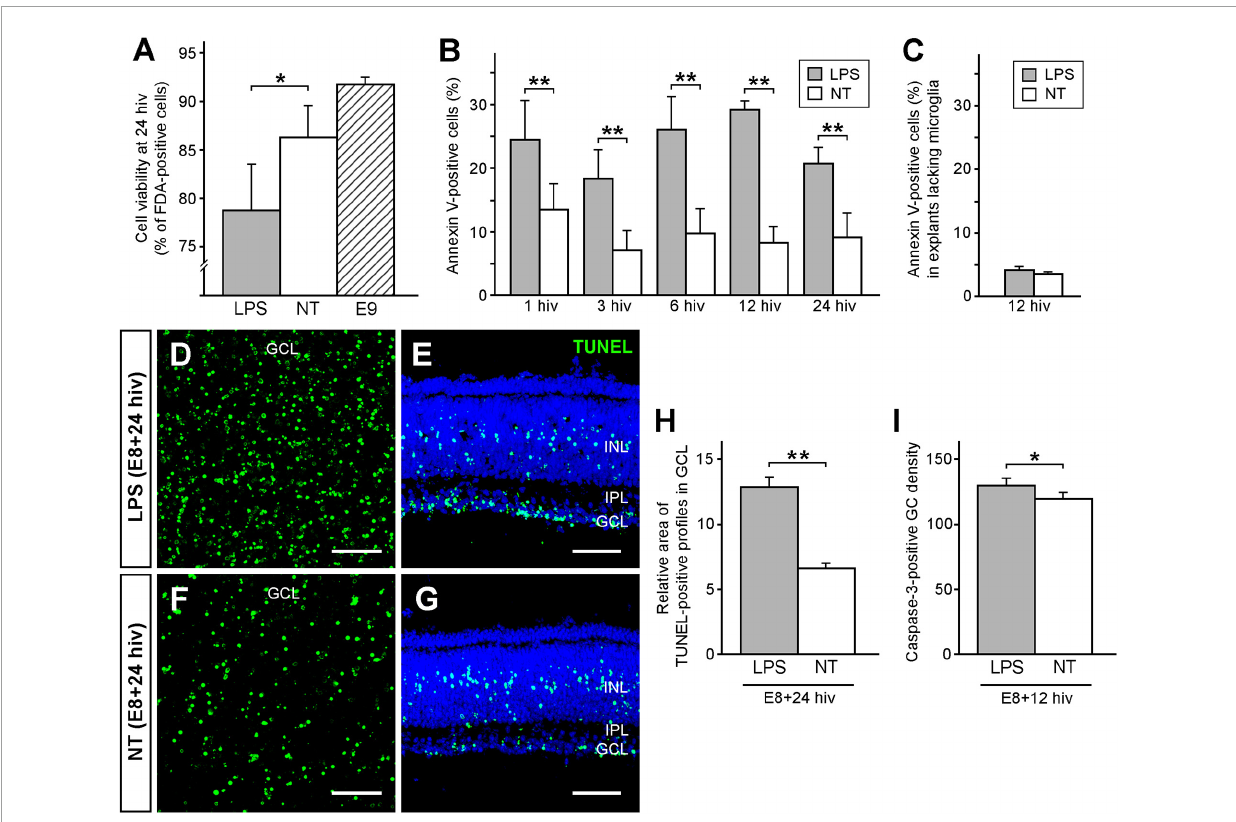
FIGURE2 LPS treatment decreases cell viability and increases cell death in retina explants prepared from quail embryos cultured for 24 h in vitro (E8 + 24 hiv). (A) Cell viability in LPS-treated (LPS, grey bar) and non-treated (NT, white bar) E8 + 24 hiv retina explants compared with that in non-cultured E9 retina explants (E9, striped bar). Cell viability is expressed as the percentage of fluorescein diacetate (FDA)-positive cells from the whole cell population, which was obtained by flow cytometry analysis of retina explant cell suspensions treated with FDA, that labels viable cells, and propidium iodide, that stains dead cells. Data are expressed as means ± SEM ( n = 9 for each condition). The percentage of viable cells is significantly lower in LPS-treated E8 + 24 hiv retina explants versus non-treated explants, while it is not significantly different between non-treated explants and non-cultured E9 retina explants (* P < 0.05, one-way ANOVA followed by Tukey test for multiple comparisons). (B) Percentages of annexin V-positive cells in E8 retina explants cultured for 1, 3, 6, 12, and 24 hiv in the presence (grey bars) or the absence (white bars) of LPS, as determined by flow cytometry analysis of cell suspensions from retina explants stained with EGFP-conjugated annexin V. Data are expressed as means ± SEM ( n = 6 for each condition). The percentages of annexin V-positive cells are significantly higher in LPS-treated than in non-treated explants at all in vitro time points (** P < 0.01, one-way ANOVA followed by Tukey test for multiple comparisons). (C) Percentages of annexin V-positive cells in E8 retina explants lacking microglia cultured for 12 hiv in the presence (grey bars) or the absence (white bars) of LPS, as determined by flow cytometry analysis of cell suspensions from retina explants stained with EGFP-conjugated annexin V. Data are expressed as means ± SEM ( n = 6 for each condition). Note that there are no significant differences between the percentages of annexin V-positive cells in LPS-treated and non-treated explants ( P = 0.14, Student’s t-test). (D–G) Representative confocal images of TUNEL-stained (green) whole-mounts (D,F) and cross sections (E,G) from LPS-treated [LPS; (D,E) ] and non-treated [NT; (F,G) ] E8 + 24 hiv retina explants. Images of whole-mounted explants are